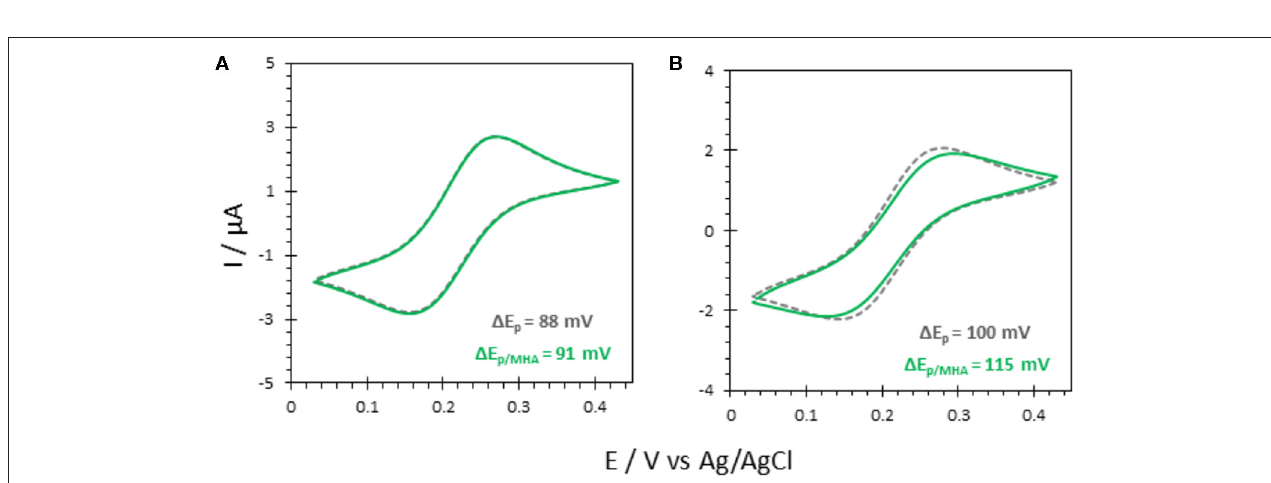
FIGURE 5 | CV responses of 5mM FeCN on (A) bare ITO and (B) AuNP@ITO (from 30nm Au film thickness) before (gray curves) and after immersion in 6-MHA (green curves). Scan rate 20 mV/s. Phosphate buffer 100mM, pH 6.